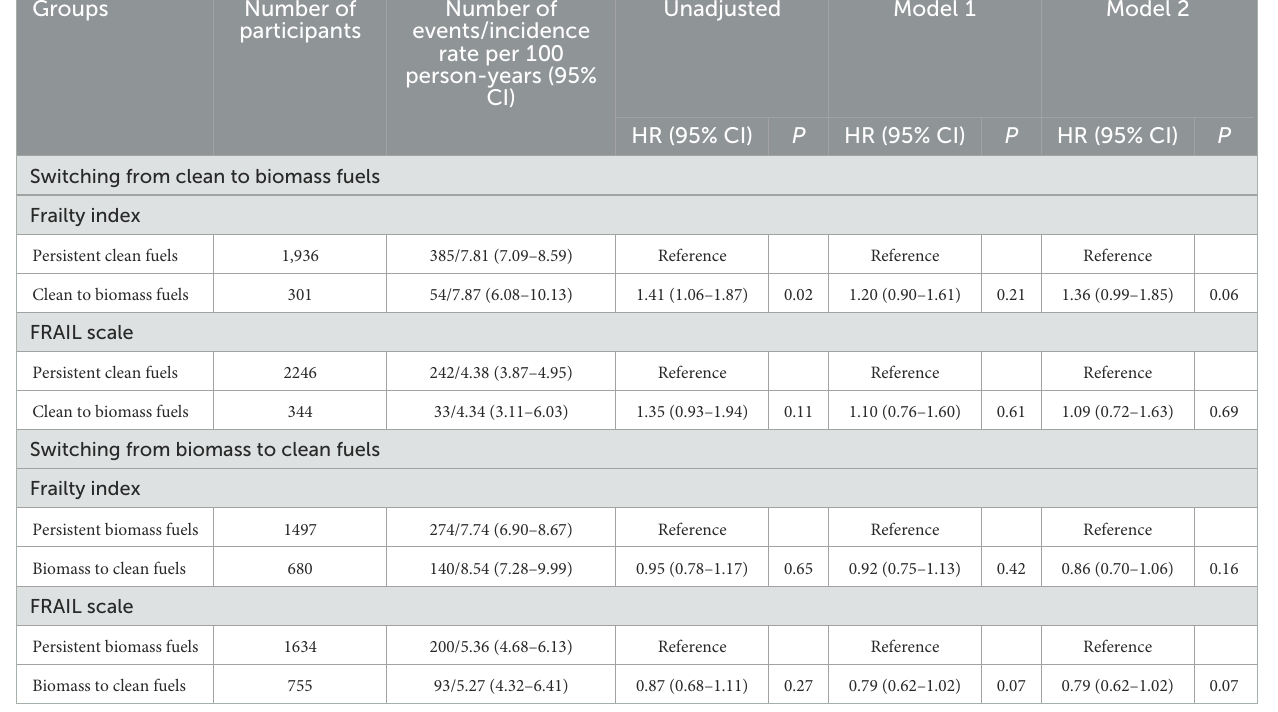
TABLE 3 The association between switching cooking fuels and frailty.